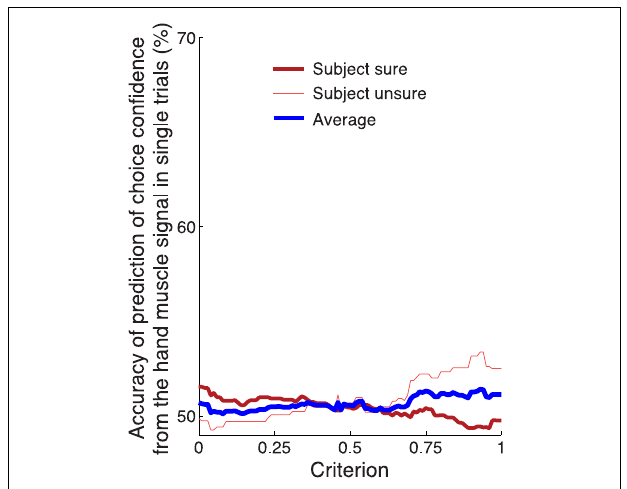
FIGURE 9 | Prediction of the confidence in a button press choice from forearm muscle activity. Same analysis and format as in Figure 8B , using the EMG activity of flexor carpi